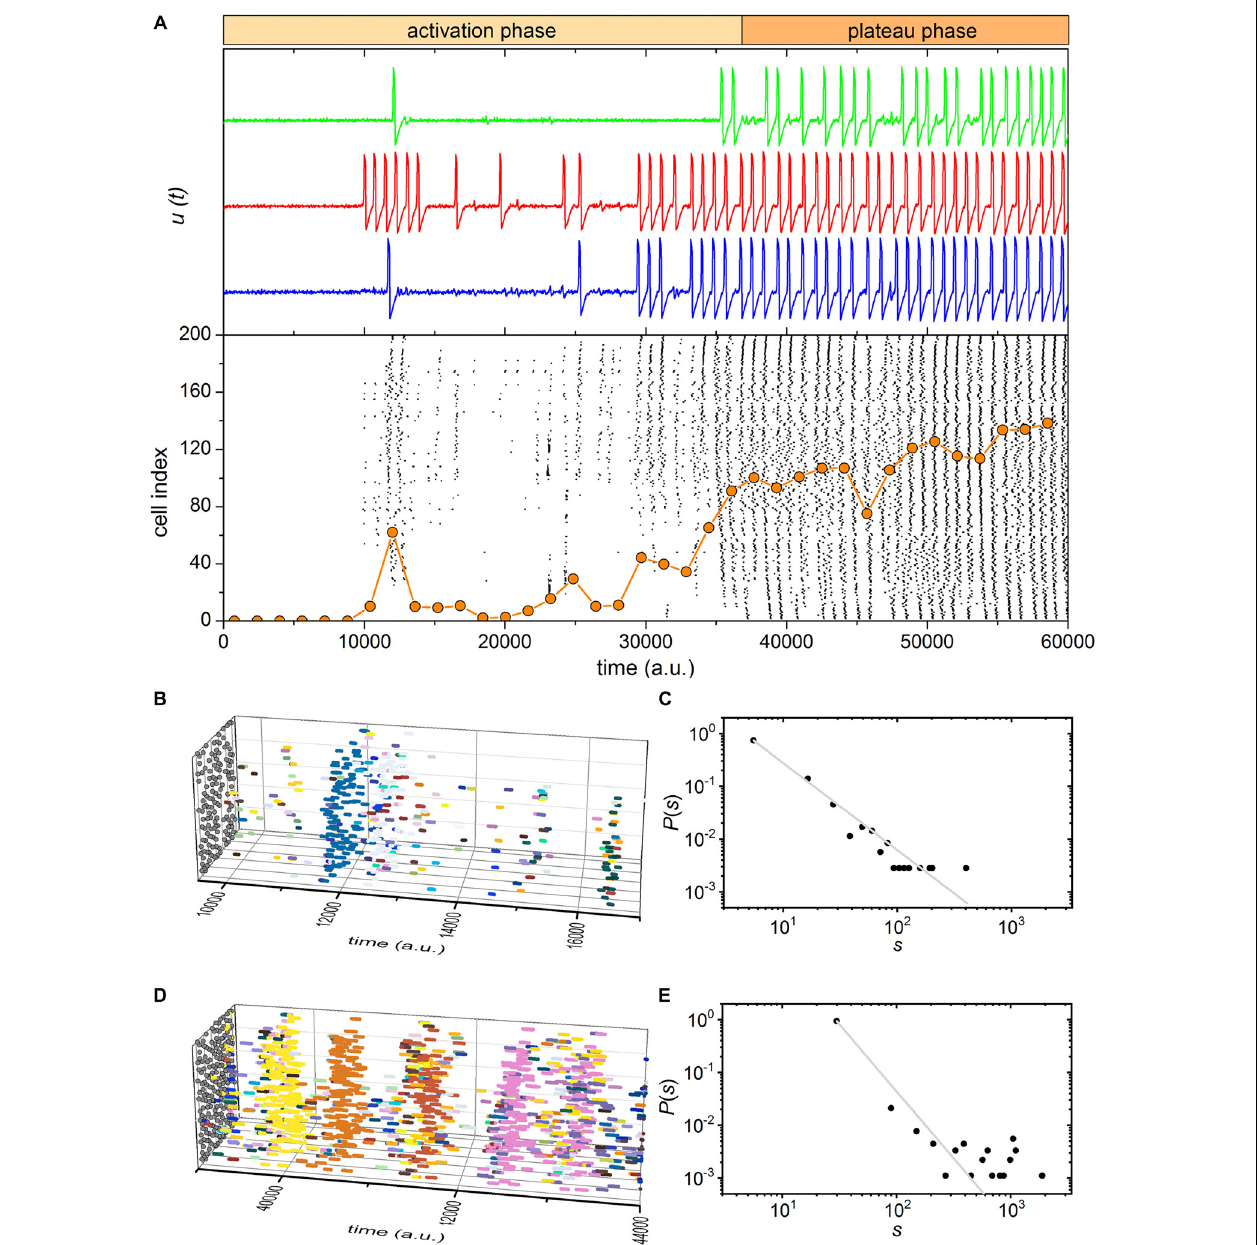
FIGURE 6 | Simulated beta cell responses after switching from a substimulatory to stimulatory levels of stimulation, i.e., from 6 to 8 mM glucose. (A) Three characteristic traces of simulated cellular dynamics and the raster plot of binarized cellular activity. The orange dotted line indicates the fraction of active cells within the given time-window that was slid throughout the simulation. (B,D) 3D raster plots showing the excitation waves for selected intervals for the activation (B) and plateau (D) phase. Colors denote individual waves. (C,E) The distributions of excitation wave sizes for the activation (C) and plateau (E) phase. The gray dashed line indicates the power-law fit. The slope in the critical-like activation phase is